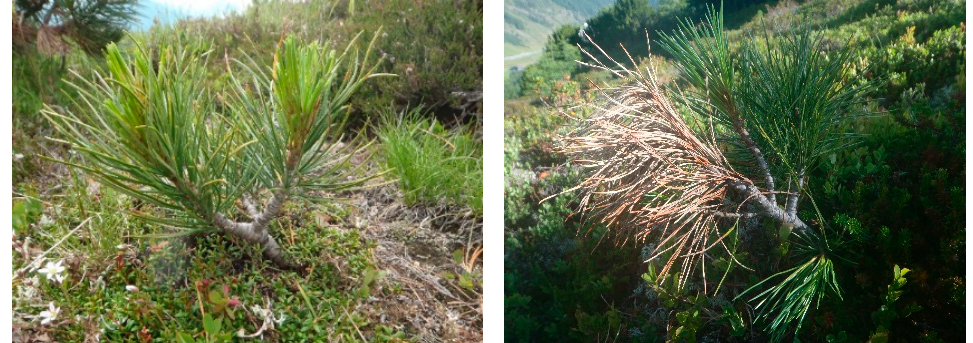
Figure 1. Pinus cembra sapling with upward-bending lateral branches ( left ) and P. cembra showing strong needle damage on the wind-exposed side caused by ice particle abrasion and winter desiccation, while sheltered leeward side remained largely undamaged ( right ).